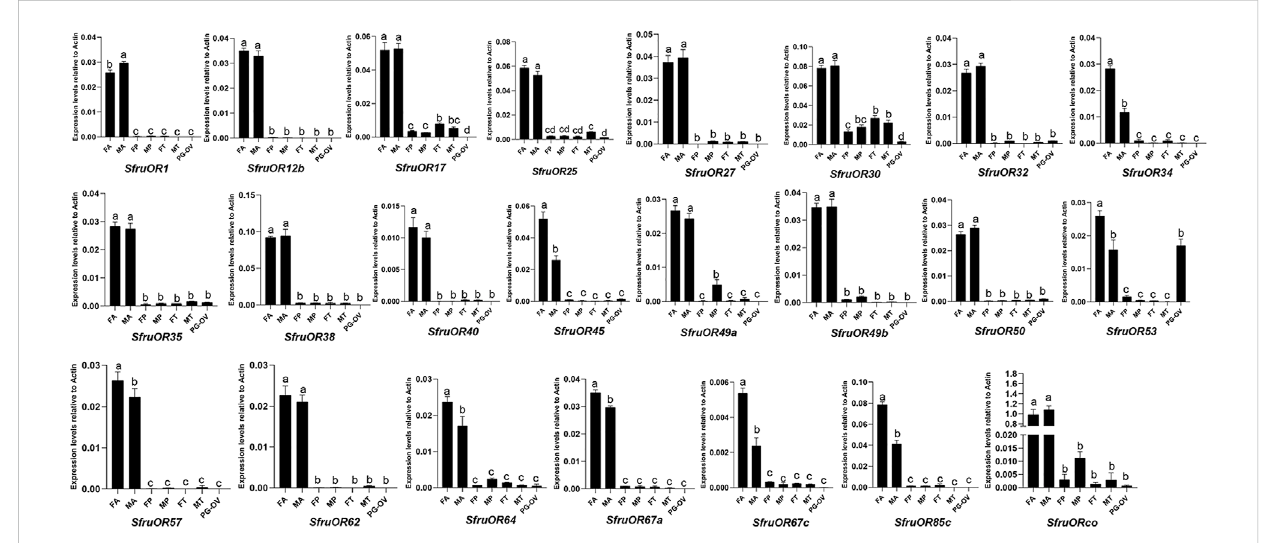
FIGURE 3 Expression patterns of candidate SfruORs in different chemosensory tissues of adult S . frugiperda . FA: female antennae, MA: male antennae, FP: female proboscises, MP: male proboscises, FT: female tarsi, MT: male tarsi, PG-OV: pheromone gland-ovipositor. Different letters indicate signi fi cant difference based on a one-way ANOVA followed by Tukey ’ s multiple comparison test. Error bars show the standard errors of the means (+SE), p < 0.05, n =